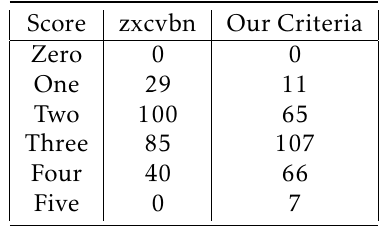
Table 2. Number of passwords with scores 0-5 in our